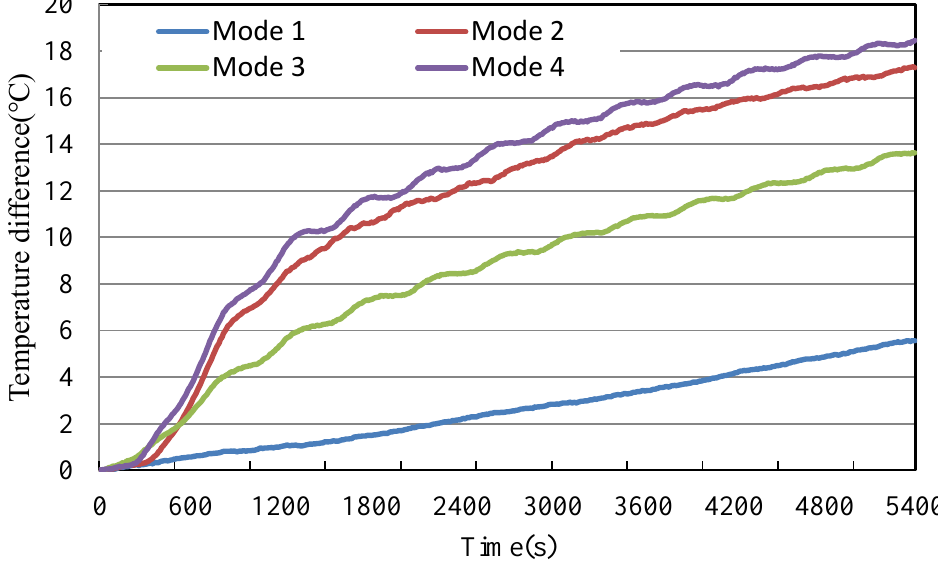
Figure 7. Floor surface temperature increase.